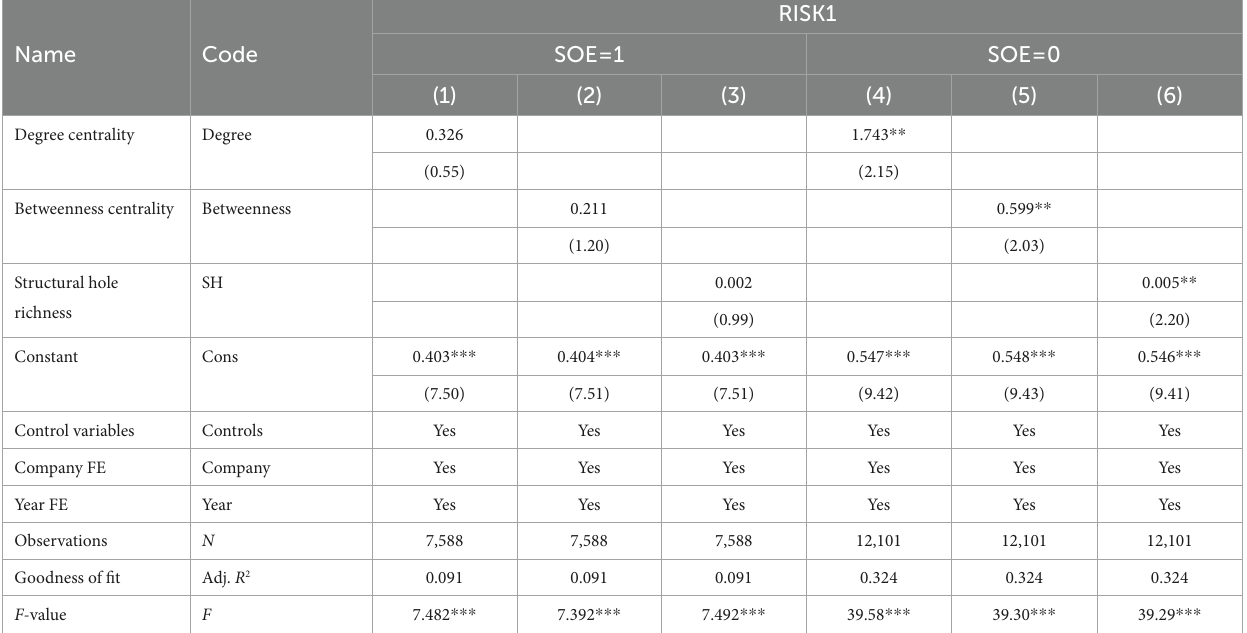
TABLE 11 Further analysis of the nature of